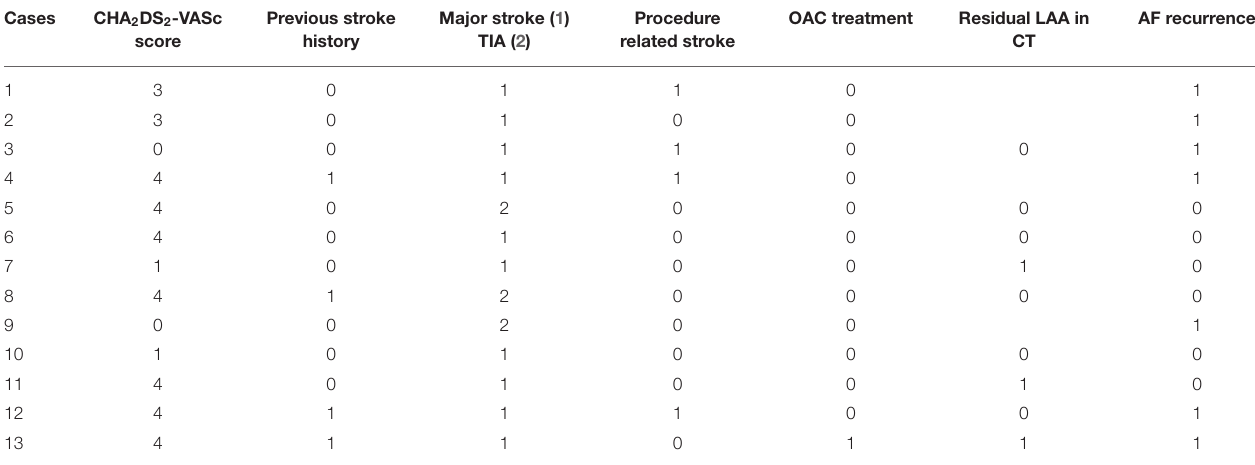
TABLE 3 | Detailed characteristics of patients who developed ischemic stroke. Cases